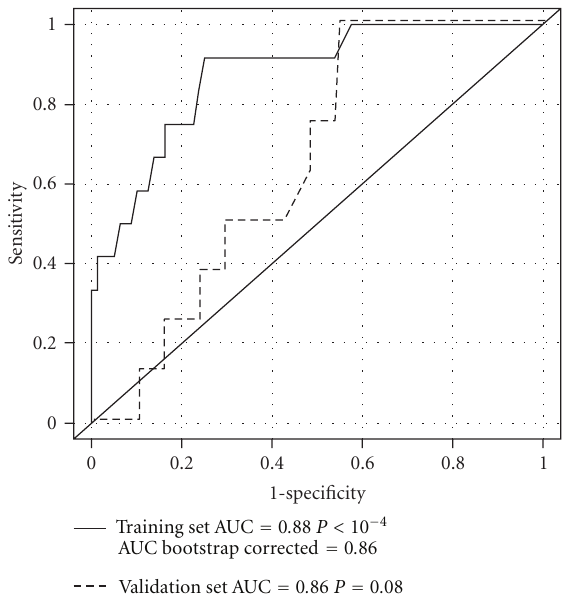
Figure 2: Receiver-operating characteristic curve of predictions from the model to predict complications in the training set (traditional suture) (plain curve) and in the validation set (TC- coated suture) (dotted curve).